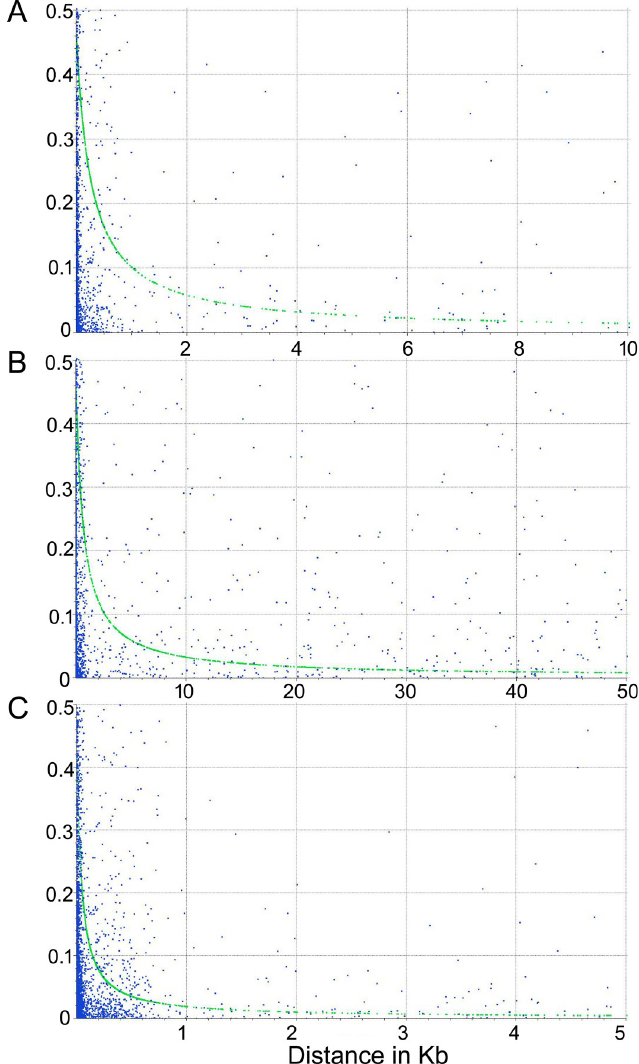
Fig 7. LD decay for (A) the whole dataset of Cynara cardunculus genotypes, (B) the globe artichoke subset, (C) cardoon samples. LD decay determined by squared correlations of allele frequencies (r 2 ) against distance between polymorphic